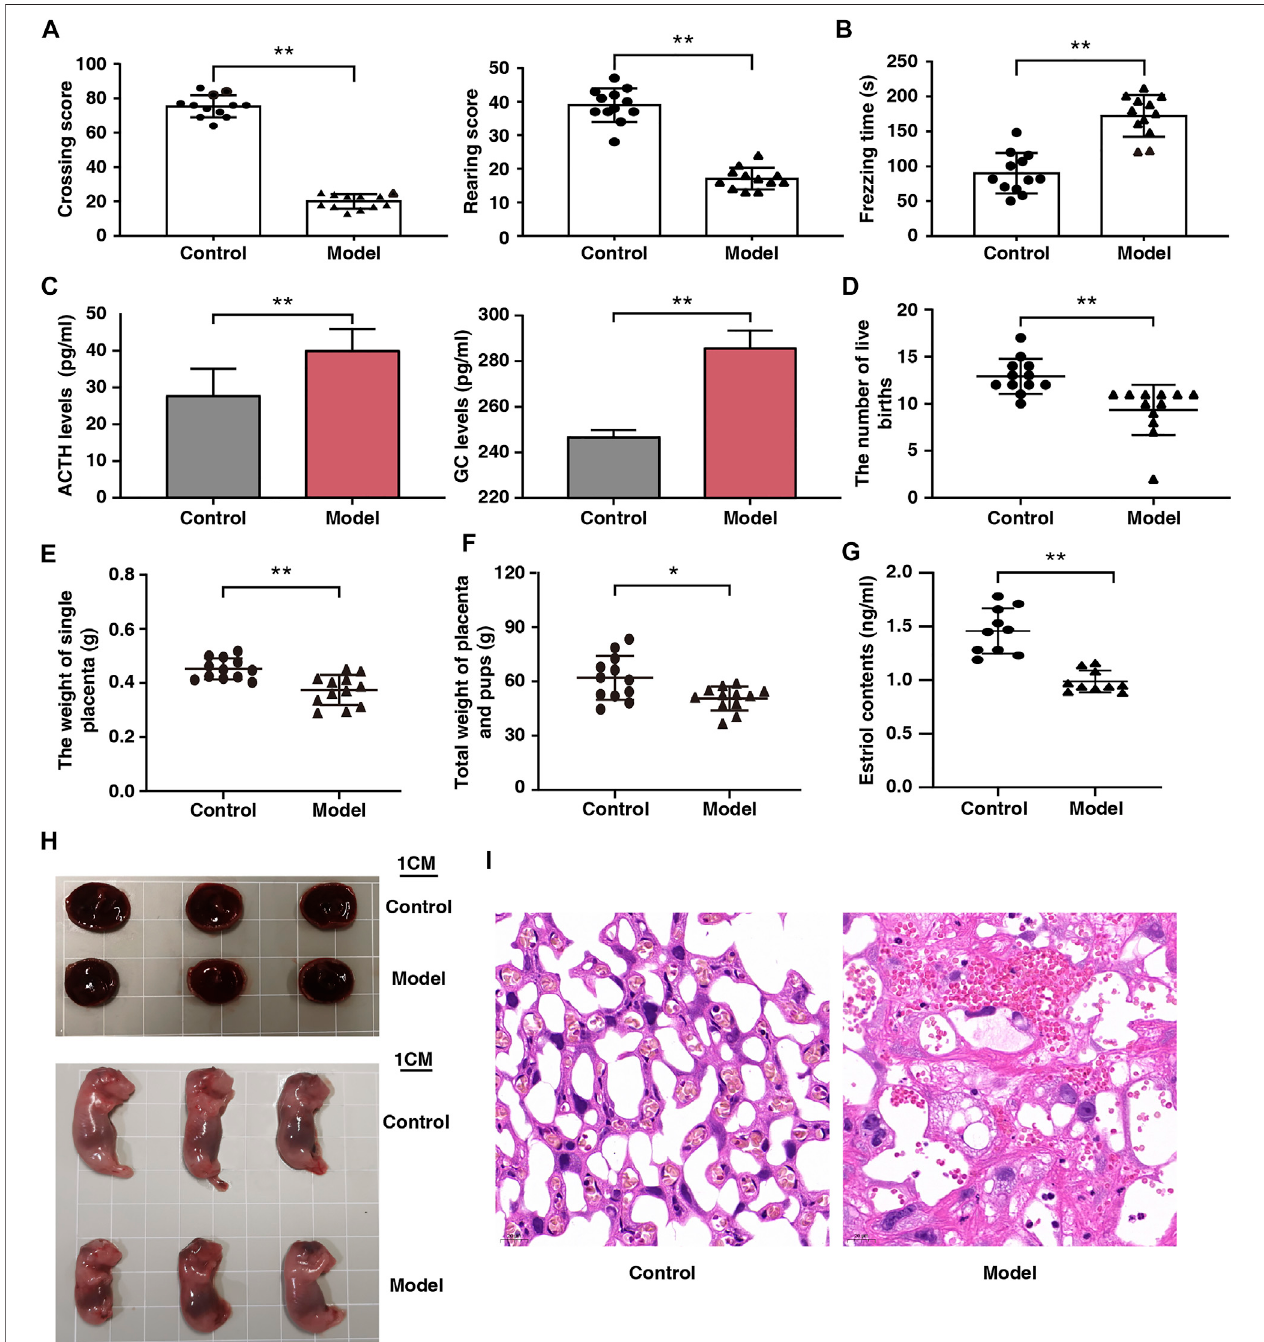
FIGURE 2 | Effect of fear stress during pregnancy on the behavior and fetal outcomes of pregnant rats. (A) Crossing and rearing scores of pregnant rats in control and model groups ( n = 12, ** p < 0.01, ** p < 0.01). (B) Freezing time ofpregnant rats in control and model groups ( n = 12, ** p < 0.01). (C) ACTH and GC levels in control and model groups ( n = 12, ** p < 0.01, ** p < 0.01). (D) The number of live birth of pregnant rats in control and model groups ( n = 12, ** p < 0.01). (E) The weight of single placenta ofpregnant rats in model and control groups ( n = 12, ** p < 0.01). (F) Total weights of the placenta and pups ofpregnant rats in control and model groups ( n = 12, * p < 0.05). (G) The estriol levels of pregnant rats in control and model groups ( n = 12, ** p < 0.01). (H) Placenta and morphological results of offspring in control and model groups (Scale bars, 1 cm). (I) Placental sections obtained from pregnant rats (stained with hematoxylin and eosin; scale bar, 20 μ m). ACTH, Adrenocorticotropic hormone; GC, Glucocorticoid.